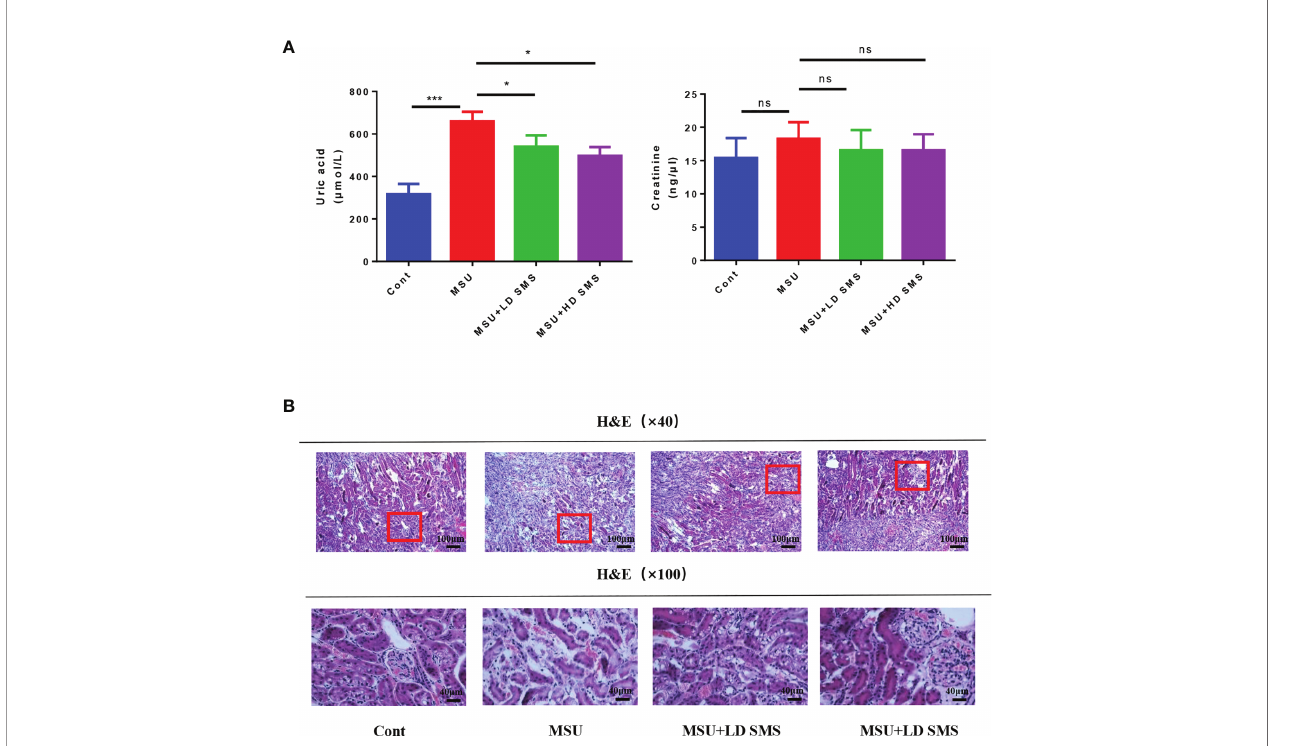
FIGURE 4 | SMS inhibit hyperuricemia in mice. Serum uric acid and serum creatinine were detected in the different groups of mice (A) . H&E staining of kidney in the different groups of mice (B) . (mean ± SEM. ns p > 0.05, *p < 0.05, ***p < 0.001; n = 6/group; LD SMS: 1mg/kg.day low dose SMS; HD SMS:10mg/kg.day high dose